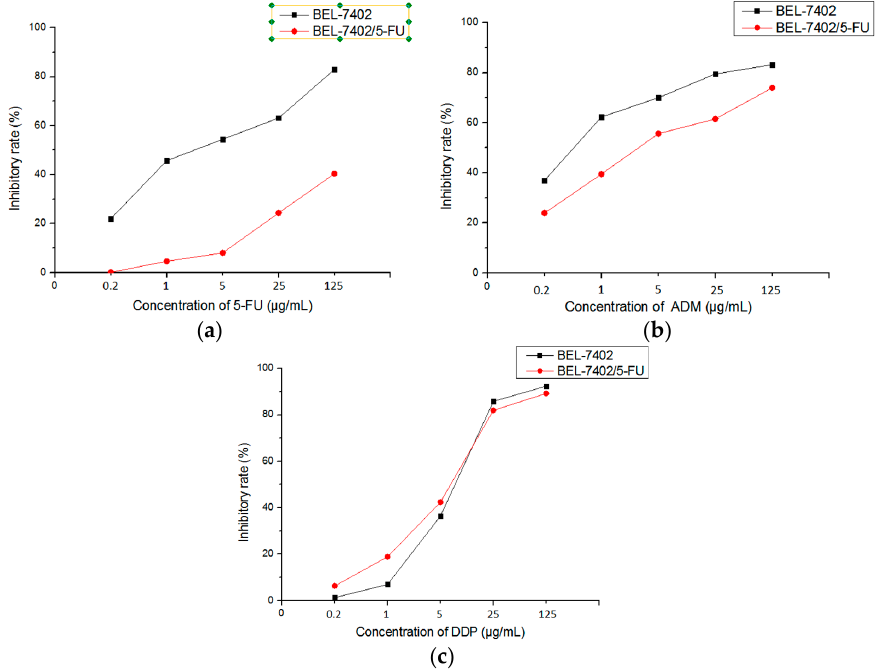
Figure 2. The inhibitory effect of chemotherapeutic drugs on BEL-7402 cells and BEL-7402/5-FU cells. ( a ) 5-FU; ( b ) ADM; ( c ) DDP.